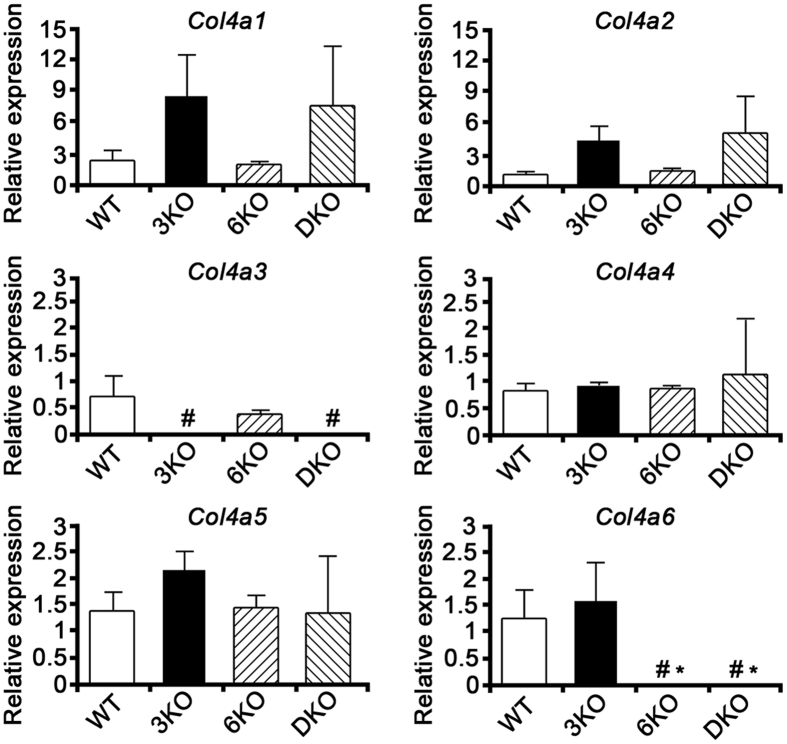
The Col4a1 and Col4a2 expressions were upregulated in Col4a3 −/− mice (3KO) and Col4a3 & 6 −/− mice (DKO) compared to wild mice (WT) and Col4a6 −/− mice (6KO).The Col4a1 expression levels in 3KO and DKO mice were 3.8 and 3.2 times higher, respectively, than that in WT mice. The expression levels of Col4a2 in 3KO and DKO mice were 4.1 and 4.6 times higher, respectively, than that in WT mice. The expression levels of Col4a3 in the 3KO and DKO mice were significantly lower than in the WT mice (#P < 0.05). The expression levels of Col4a5 in 3KO and DKO mice were 1.6 and 1 times higher, respectively, than that in WT mice. Finally, the expression level of Col4a6 in 3KO mice was 1.3 times higher than that in WT mice, while the expression levels of Col4a6 in the 6KO and DKO mice were significantly lower than those of the WT and 3KO mice (#P < 0.05 versus WT, *P < 0.05 versus 3KO).